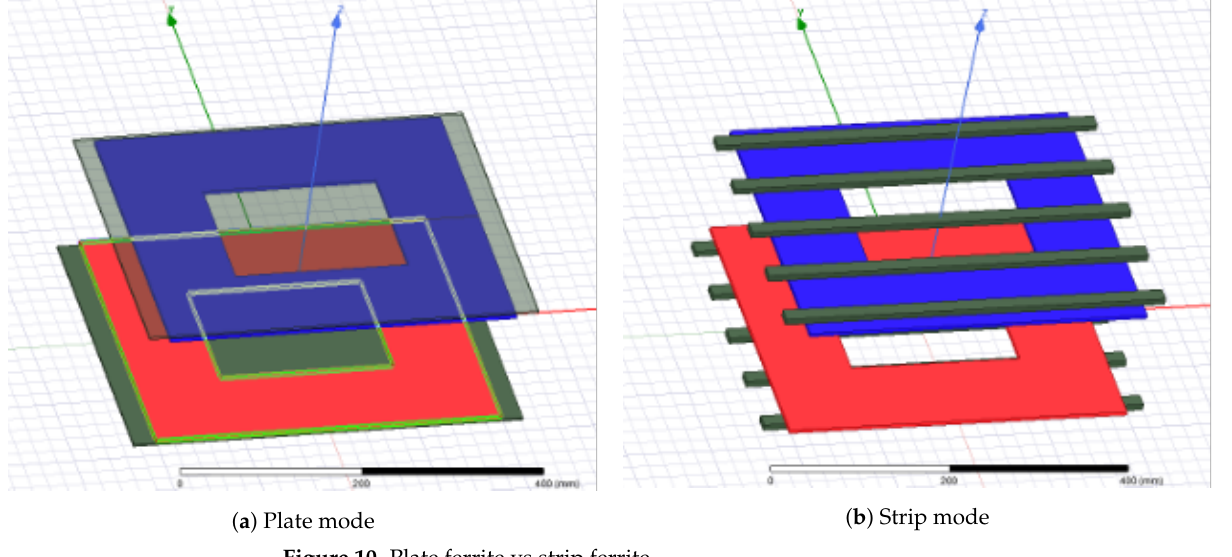
Figure 10. Plate ferrite vs strip